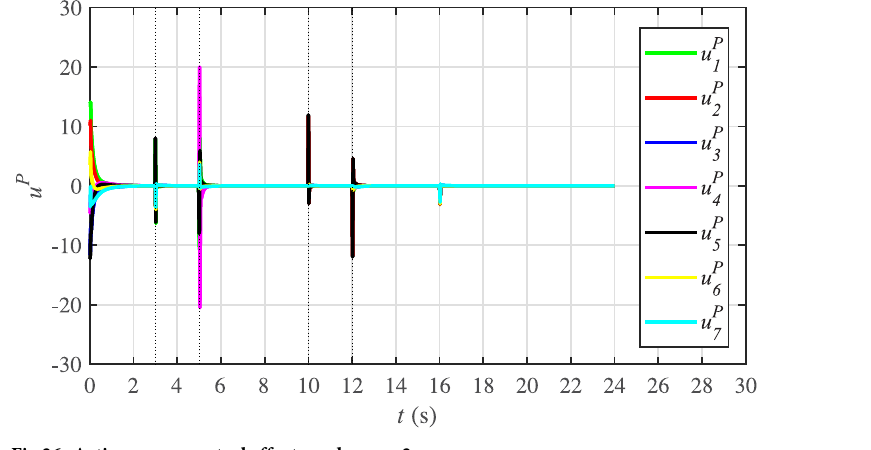
Fig 26. Active power control efforts under case